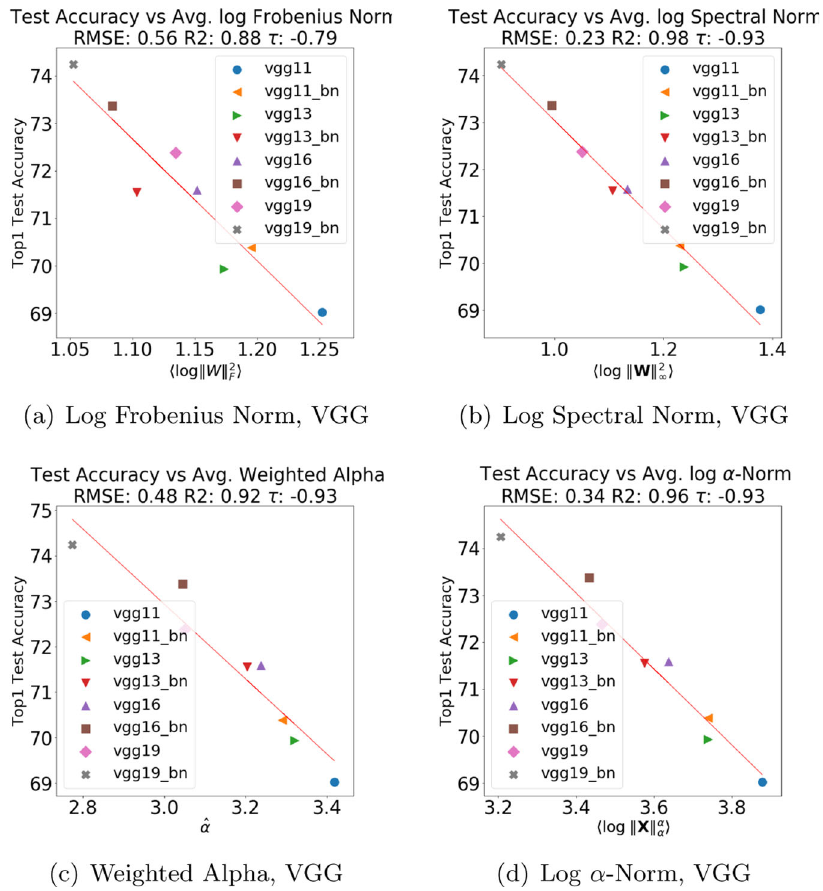
Fig. 2 Comparison of average Log Norm and Weighted Alpha quality metrics for CV models. Comparison of average Log Norms (in ( a ), ( b ), and ( d )) and Weighted Alpha (in ( c )) quality metrics versus reported test accuracy for pretrained VGG models: VGG11, VGG13, VGG16, and VGG19, with and without Batch Normalization (BN), trained on ImageNet, available in pyTorch (v1.4). Metrics fi t by linear regression, RMSE, R2, and the Kendal-tau rank correlation metric reported.